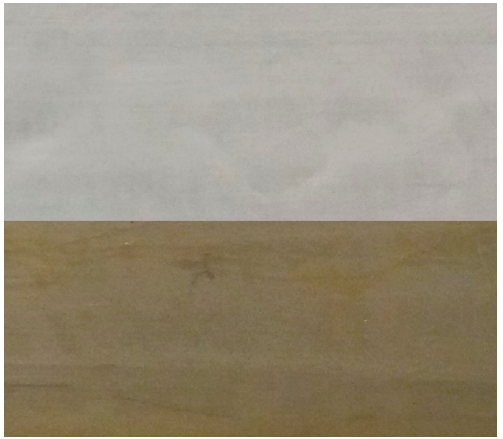
Figure 2. Visual inspection of an epoxy resin showing discoloration due to hygrothermal aging. initial (blueish grey); bottom : redried after conditioning (yellow). Top : initial (blueish grey); bottom : redried after conditioning